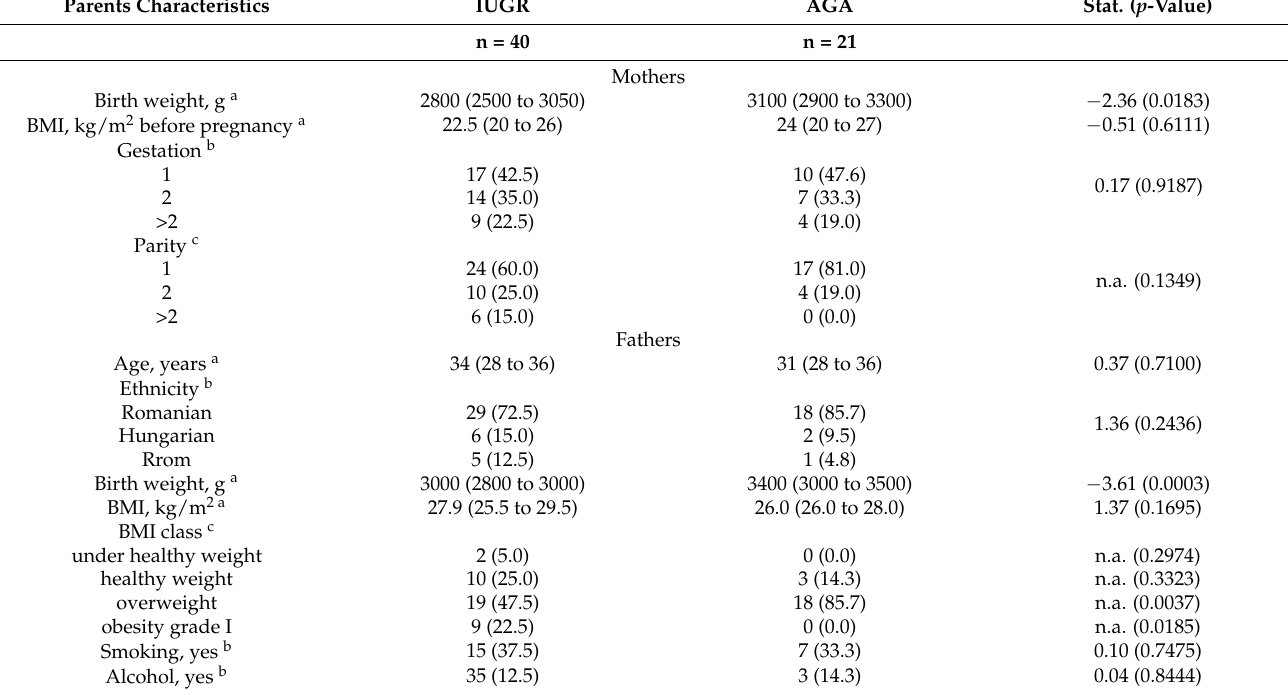
Table 1. Mothers’and fathers’ characteristics by groups.